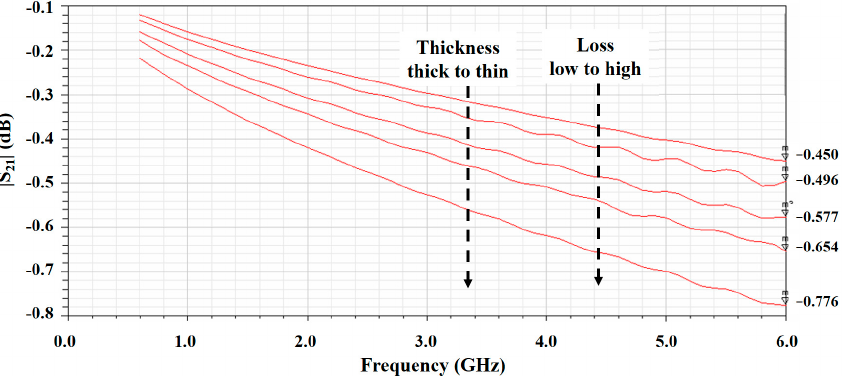
Figure 14. Simulation results of total thickness investigations.